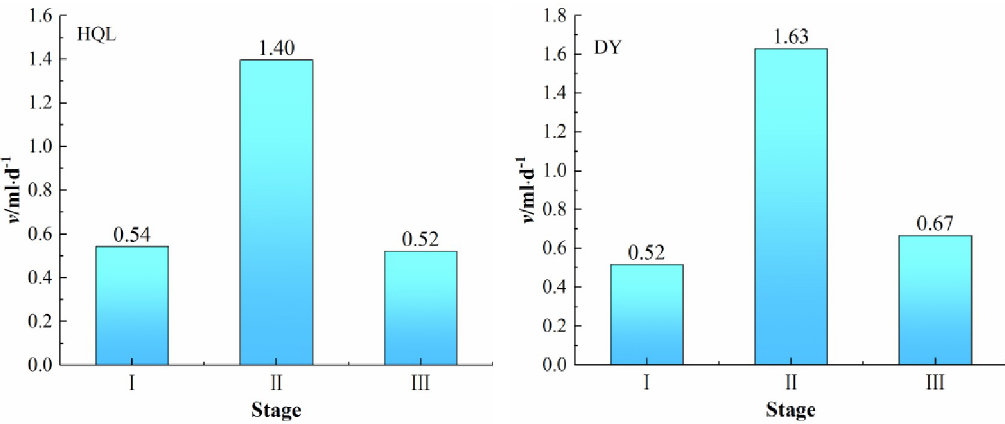
Fig 6. Comparison of the average water production rate in different stages of the upward process of coal spontaneous combustion.